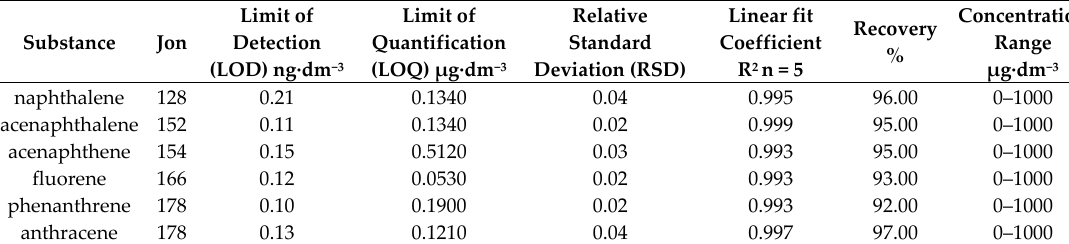
Table 1. Gas chromatography (GC) method validation